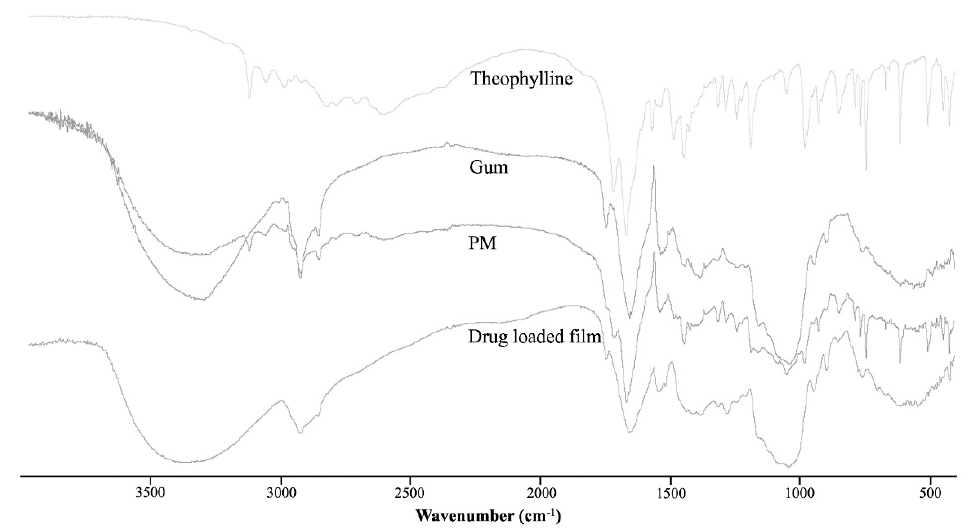
Figure 5. FTIR spectra for theophylline, gum, their physical mixture (PM), and the drug-loaded film.